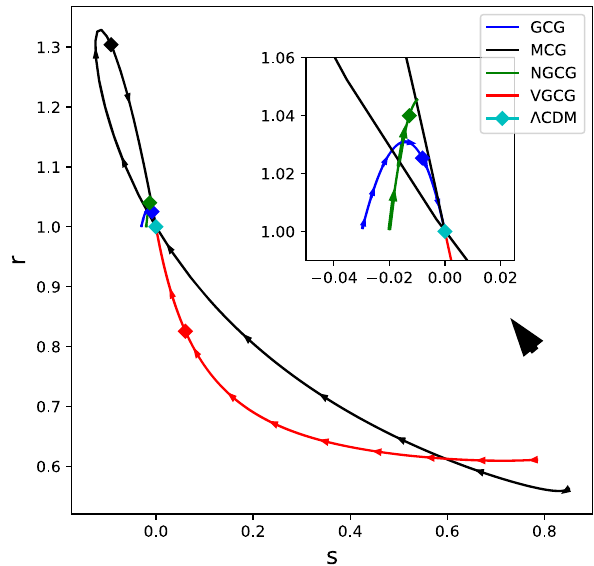
Fig. 8 The evolution of the statefinder pair ( r , s ) for different cosmo- logical models. The cyan diamond point at ( r , s ) = ( 1 , 0 ) indicates the Λ CDM model, and the other diamond point on each curve denotes the present value of the statefinder pair ( r , s ) for the GCG, MCG, NGCG, and VGCG models. The model parameters adopted in statefinder diag- nostic are from the combination of QSO[XUV], SNe Ia, QSO[AS] and BAO in Table 2